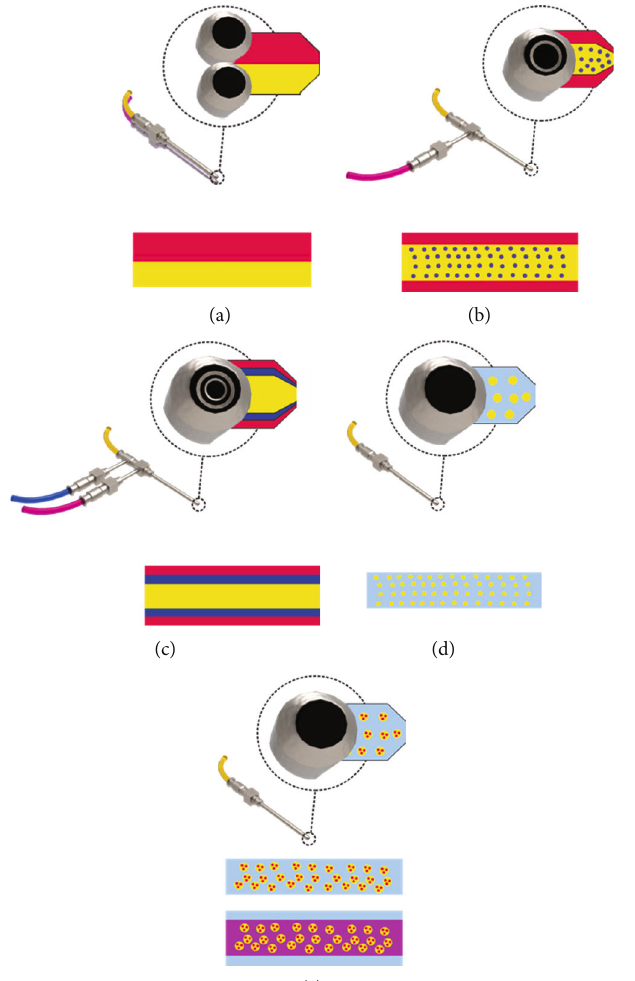
Figure 2: Schematic of some di ff erent types of electrospinning. (a) Side-by-Side side Electrospinningelectrospinning. (b) Coaxial Electrospinningelectrospinning. (c) Multiaxial Electrospinningelectrospinning. (d) Blending Electrospinningelectrospinning. (e) Emulsion